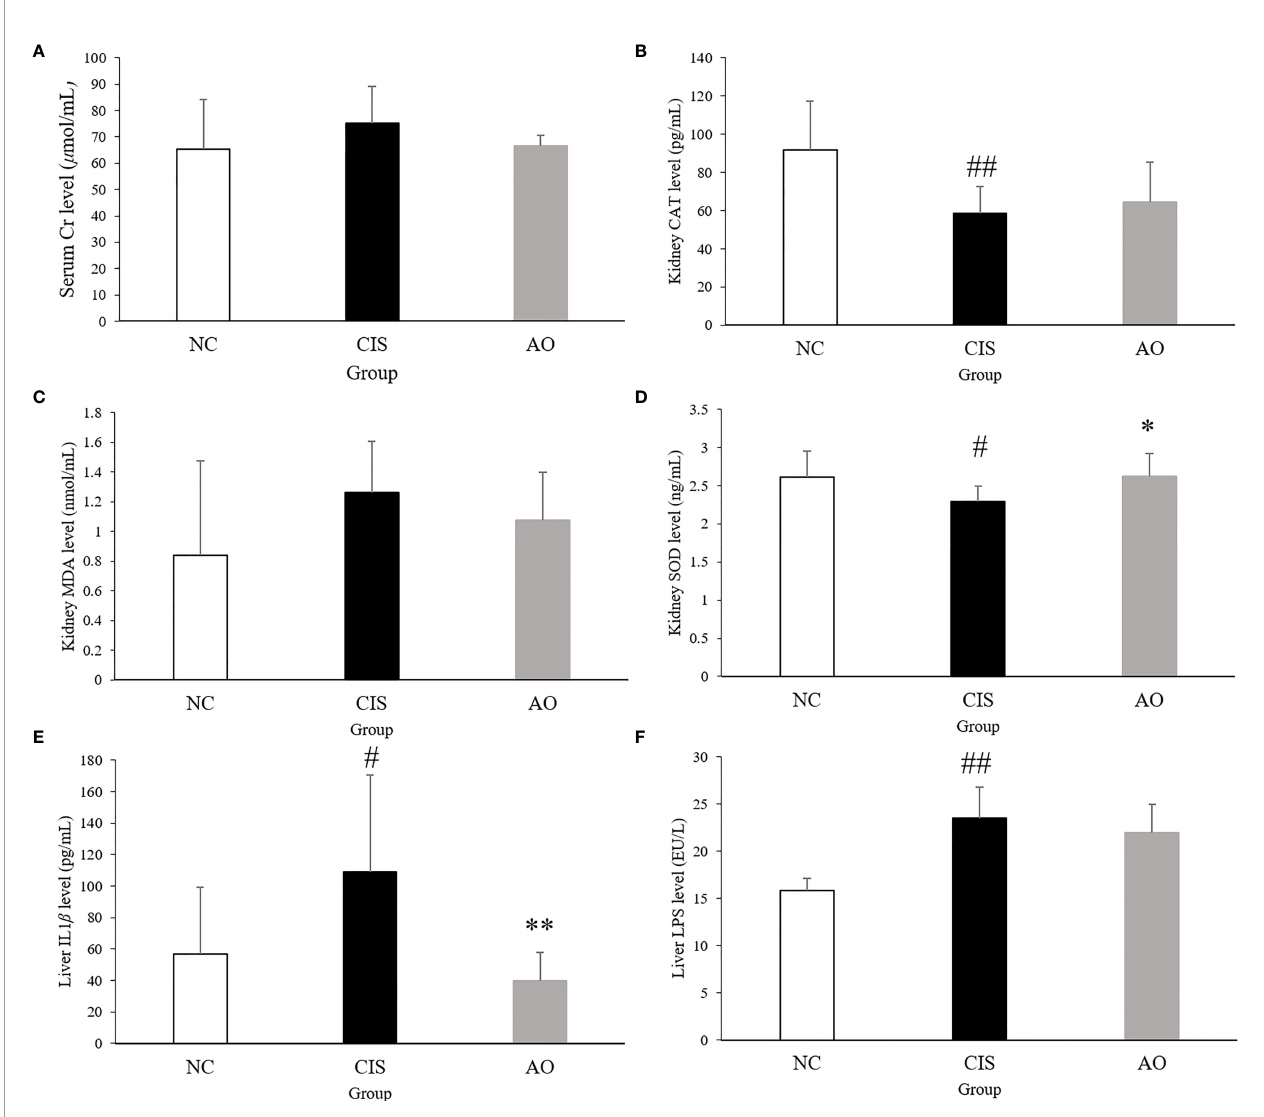
FIGURE 1 | Biochemical parameters and oxidative stress analysis in renal and hepatic tissues. (A) serum Cr level; (B) kidney CAT level; (C) kidney MDA level; (D) kidney SOD level; (E) liver IL1 b level; (F) live LPS level. n=10 for the AO and NC groups, n=7 for the CIS group (three mice in the CIS group died before euthanasia.) The signi fi cance marker on AO indicates AO vs. CIS (* p < 0.05, ** p < 0.01); the signi fi cance marker on CIS indicates CIS vs. NC ( # p < 0.05, ## p <